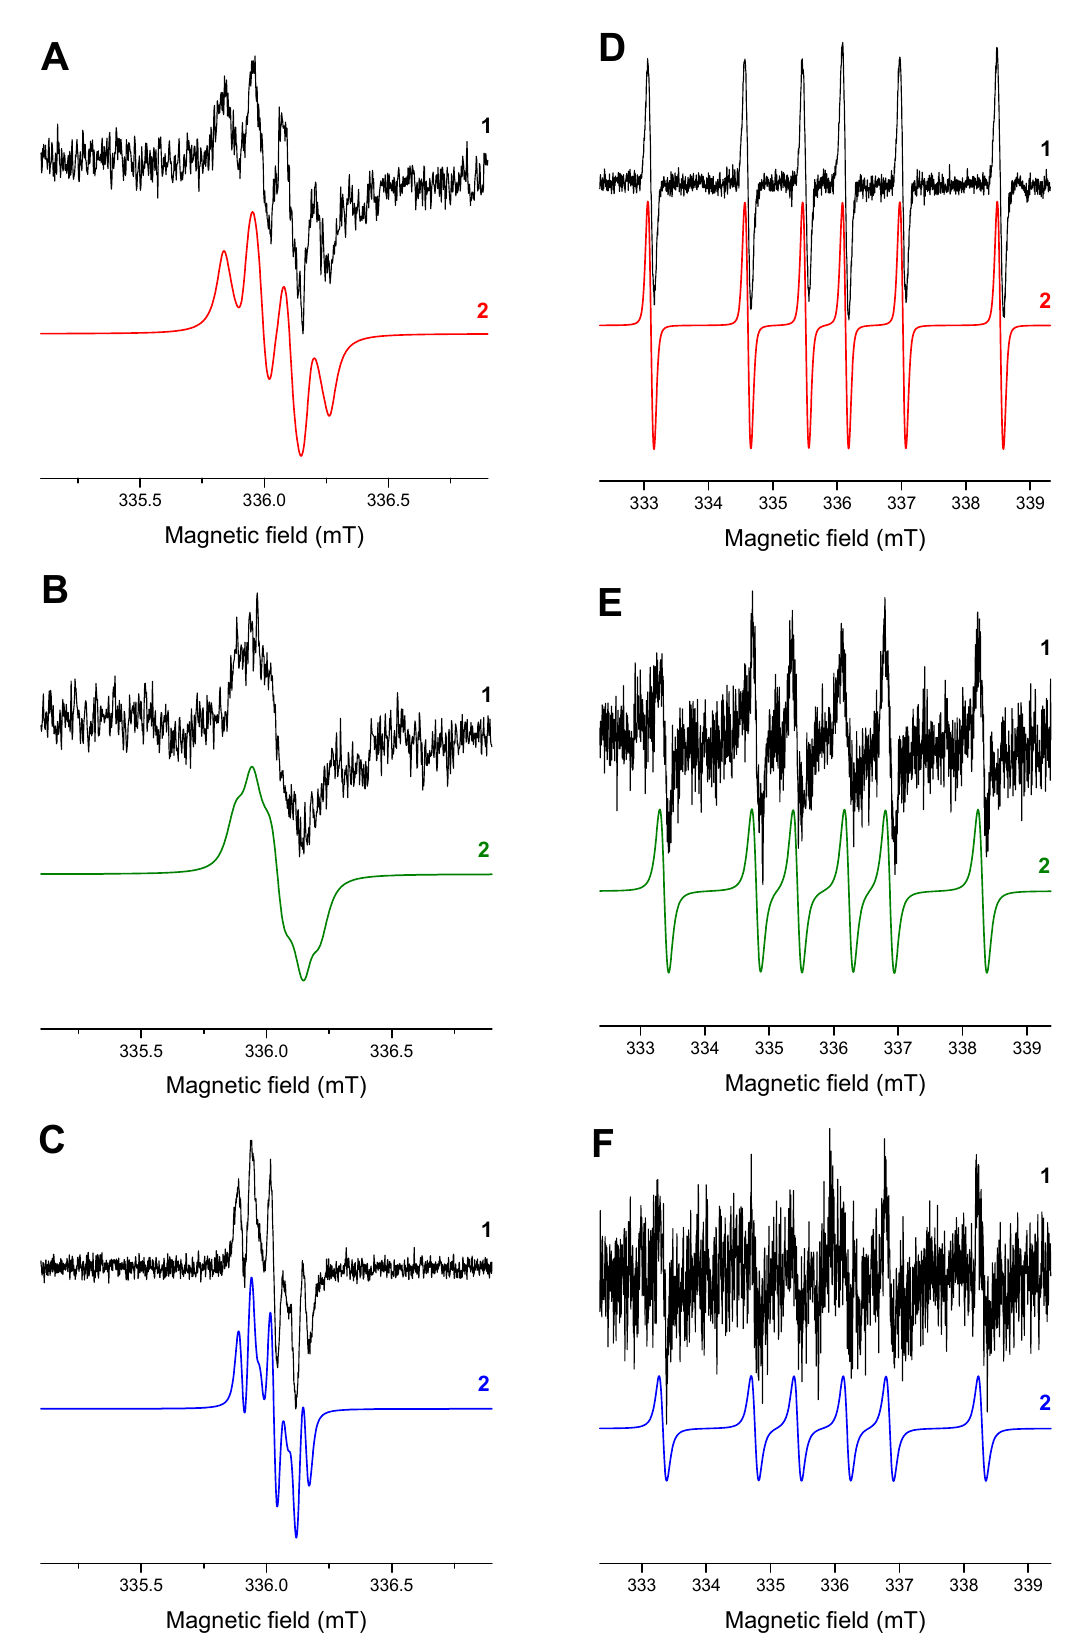
Figure 2. The normalized experimental (1) and simulated (2) EPR spectra obtained upon continuous in situ LED@400 nm exposure: ( A ) HNQ, ( B ) HNQA, ( C ) HNQE, ( D ) HNQ/DMPO, ( E ) HNQA/DMPO, and ( F ) HNQE/DMPO in acetonitrile under argon. Modulation amplitude: 0.1 mT ( A , B ) and 0.025 mT ( C – F